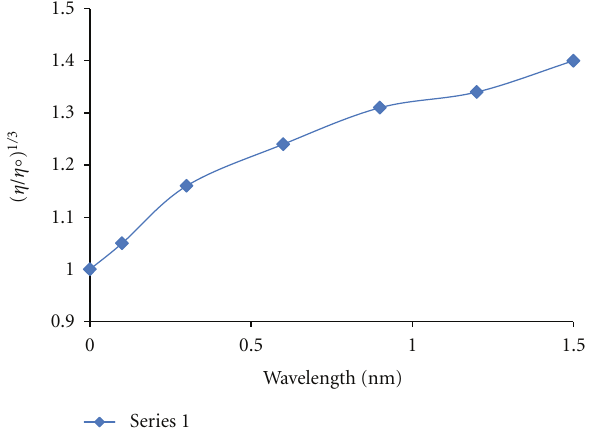
Figure 4: E ff ect of increasing amounts of Pt(II) complex on the vis- cosity of CT-DNA (5 × 10 − 5 M) in 10 mM Tris-HCl bu ff